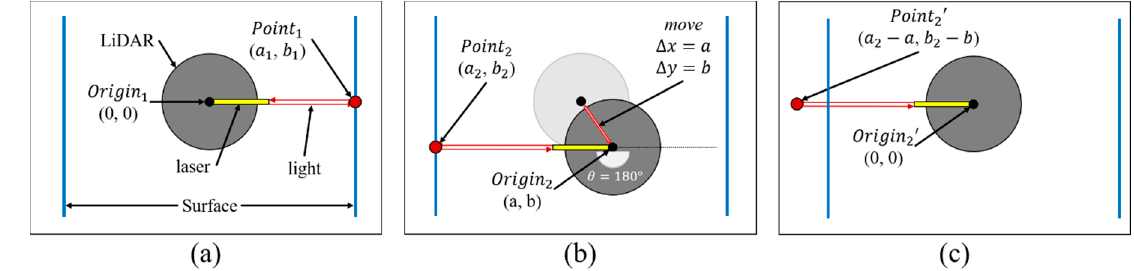
Figure 1. ( a ) 3D scanning by LiDAR at θ = 0 ◦ ; ( b ) 3D scanning by LiDAR at θ = 180 ◦ ; ( c ) Integration error of point captured at θ = 180 ◦ . LiDAR: light detection and